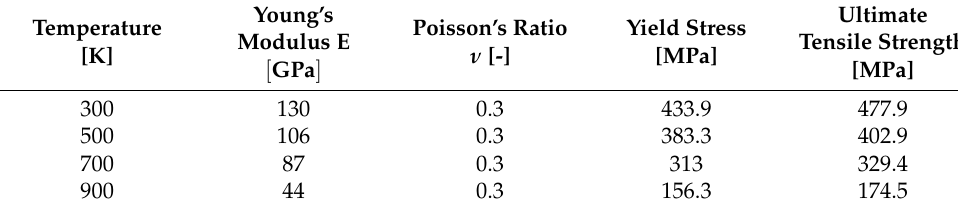
Table 3. Mechanical properties of CuCrZr.